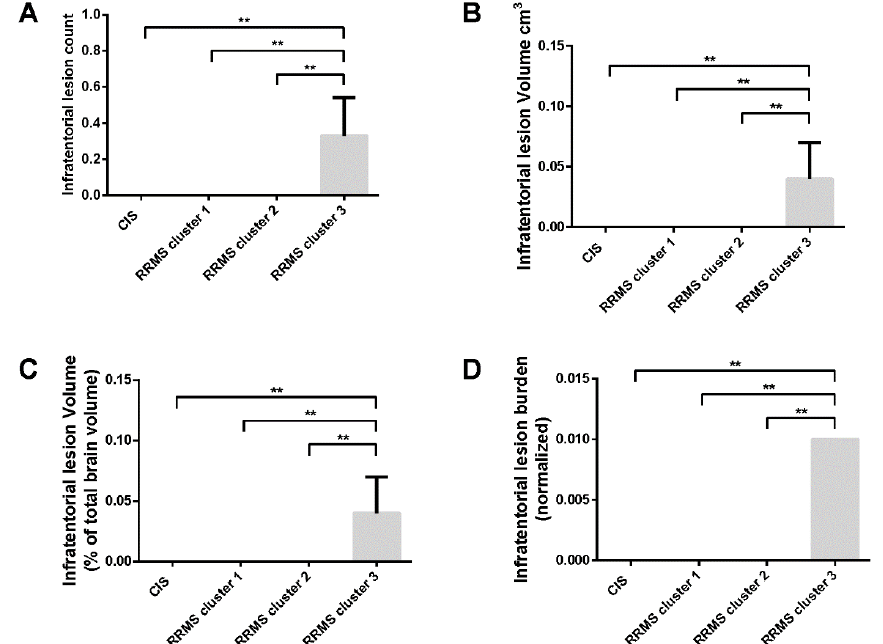
Figure 5. Magnetic Resonance Imaging lesion analysis with respect to infratentorial lesion parameters for patients with Clinically Isolated Syndrome and Relapsing-Remitting Multiple Sclerosis stratified into three clusters (1–3) derived from Hierarchical Cluster Analysis on the basis of serum metabolomic profile. CIS: Clinically Isolated Syndrome; RRMS: Relapsing-Remitting Multiple Sclerosis. Brackets indicate post-hoc comparisons. Bars and error bars represent mean ± standard error of mean. ** p < 0.01. The patient groups did not differ with respect to other volumetry and/or lesion anal- ysis parameters on brain MRI (Supplementary Table S2). Although patients with RRMS cluster 3 exhibited a higher mean number of spinal T2 lesions compared to patients with CIS and patients with RRMS clusters 1 and 2, the difference did not reach statistical sig- nificance (2.7 ± 1.02 vs. 0.6 ± 0.16, 1.8 ± 0.45 and 2 ± 0.53, respectively, F = 2.069, p = 0.12; Table 3). When the mean number of infratentorial and spinal T2 lesions in total was com- pared across patient groups, a tendency for a significant difference was evident (F = 2.587, p = 0.068; Table 3), attributed to a tendency for increased mean number of lesions in pa- tients with RRMS cluster 3, compared to patients with CIS (3 ± 0.86 vs. 0.56 ± 0.18, p = 0.057). 2.5. Distinct Serum Metabolomic Profile in Patients with RRMS Cluster 3, Compared to Patients with RRMS Clusters 1 and 2 A total of 11 serum metabolites, namely alanine, asparagine, glutamine, methionine, phenylalanine, arginine, acetylcarnitine, cystine, pyruvic acid, lactic acid and 2-hydroxy- butyric acid exhibited increased concentrations in patients with RRMS cluster 3 compared to patients with RRMS clusters 1 and 2, thus underlining an, at least in part, distinct serum metabolomic profile in patients with RRMS cluster 3 compared to the other patients with RRMS. Serum glucose was evidently increased in patients with RRMS cluster 3 compared to patients with RRMS cluster 2, whereas it was comparable between clusters 3 and 1. Similarly, mannose and uridine exhibited reduced serum concentration in patients with